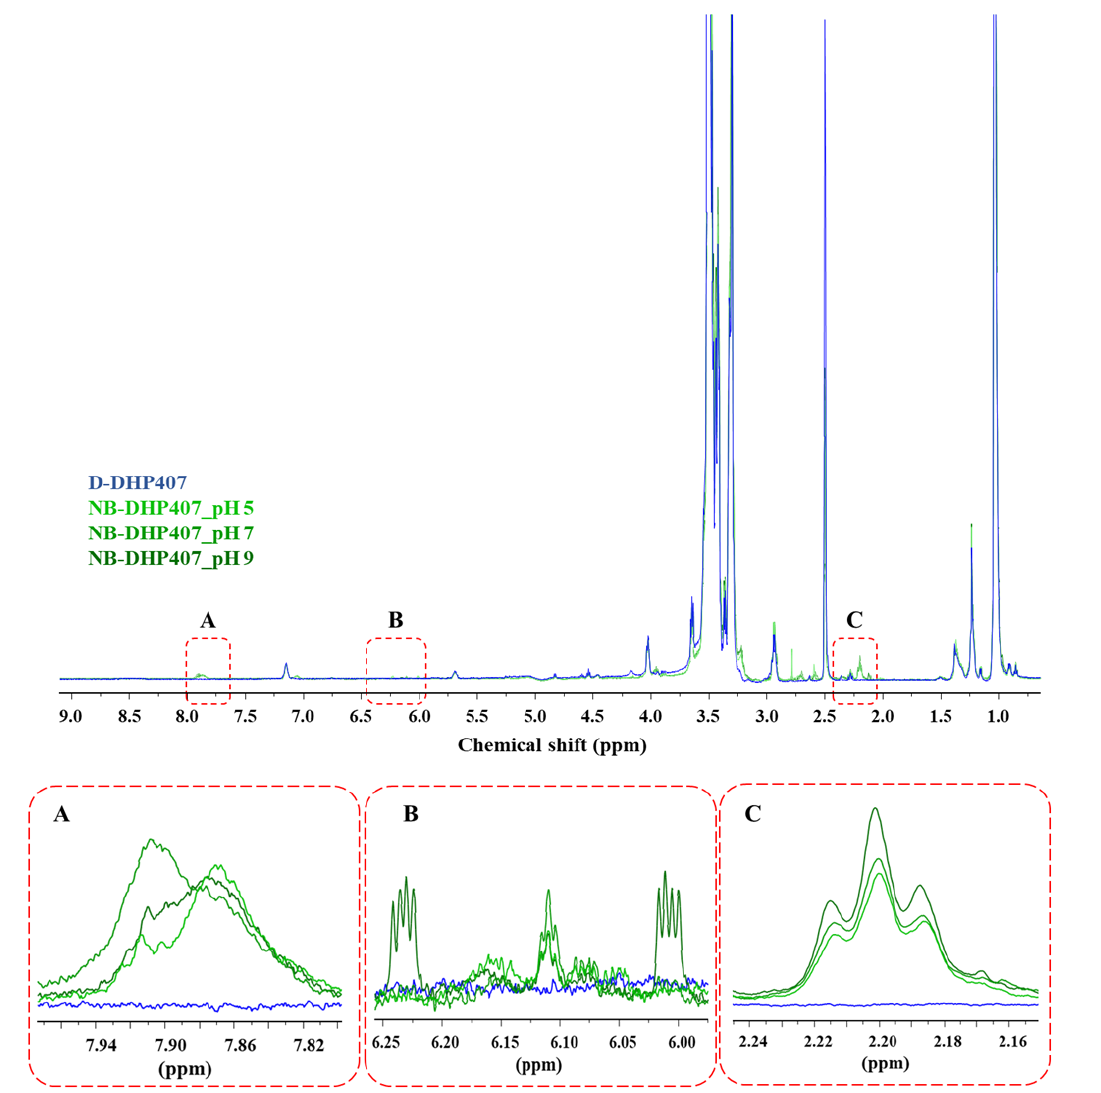
Figure 5. 1 H NMR spectra of D-DHP407 (blue, control condition) and NB-DHP407_pHX (green) samples. The increasing color intensity of the spectrum stands for the increasing reaction pH from 5 to 9. Magnified insert A highlights the signals attributed to the –NH groups of amides; magnified insert B highlights that both endo or exo forms of NBE were successfully grafted to PEU backbone with a pH-dependent yield (the peak at 6.1 ppm can be attributed to the exo -NBE, while the peaks at 6.0 and 6.25 ppm can be ascribed to the endo -NBE); magnified insert C evidences the triplet at 2.20 ppm due to the resonance of the aliphatic protons of NBE molecules.